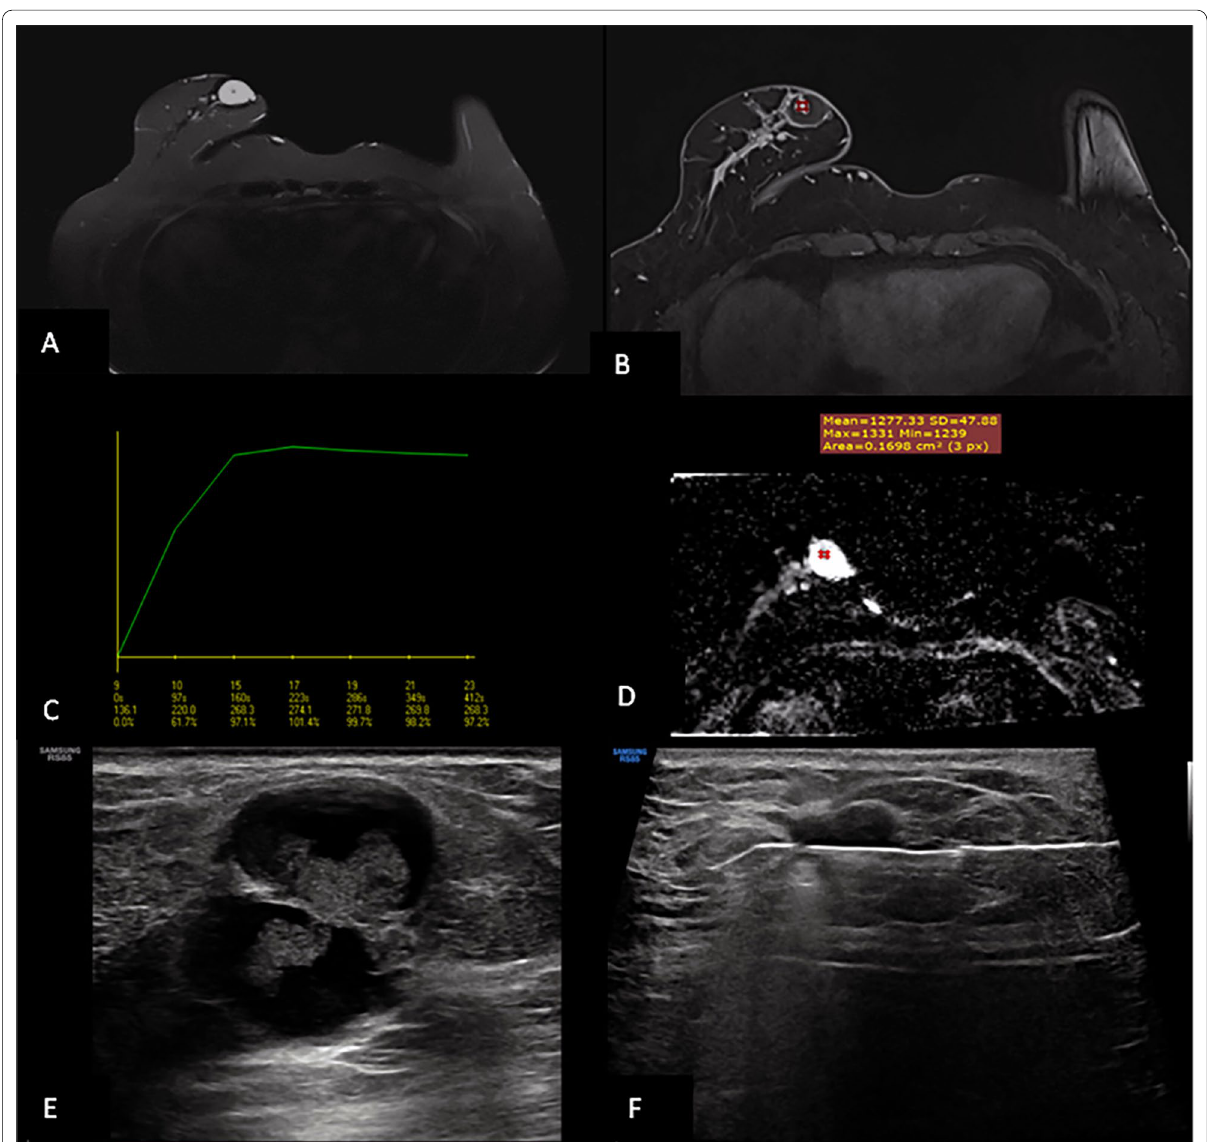
Fig. 2 Case 1: 45 years old with strong family history and pathologically proven left breast IDC showing multiple bilateral complex cystic lesions on sonomammographic assessment (not illustrated on images). DCE‑MRI: STIR ( A ), post‑contrast dynamic sequences ( B ) with time–intensity curves ( C ), and ADC mapping ( D ) revealed bilateral cystic lesions with intralesional soft tissue components showing mass enhancement ( B ) On plotting the time–intensity curve, the lesions revealed type II (plateau curve) ( C ). The mass showed facilitated diffusion and ADC value of 1.28 ( D ). Given the patient’s history of contralateral breast cancer, U/S guided VAB‑assisted excision of bilateral breast lesions ( E & F ) revealed intraductal papilloma, UDH, and ADH. Surgical excision revealed low‑grade